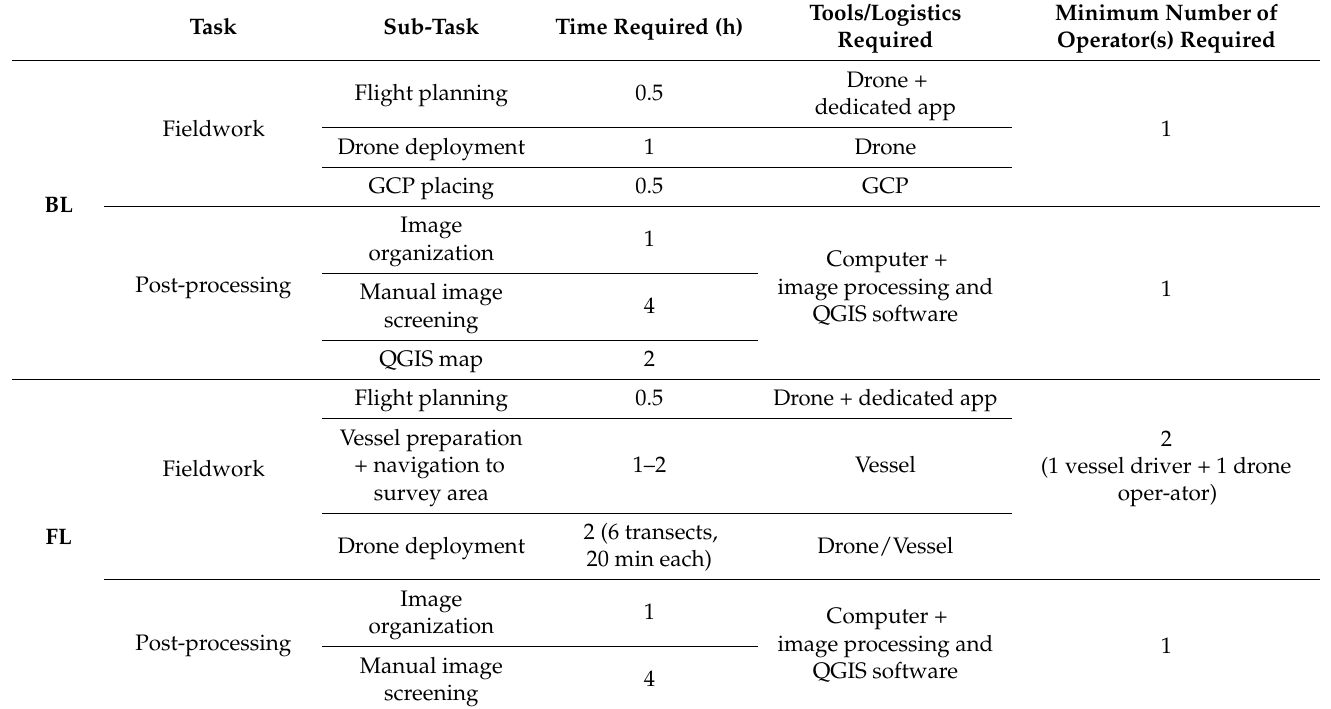
Table 3. Approximate time required to assess a drone-based survey of beached (BL) and floating (FL) litter survey. Main tasks are divided into fieldwork and image post-processing. The different steps to carry out the final assessments, as well as the required tools and software for the aim, are indicated in the